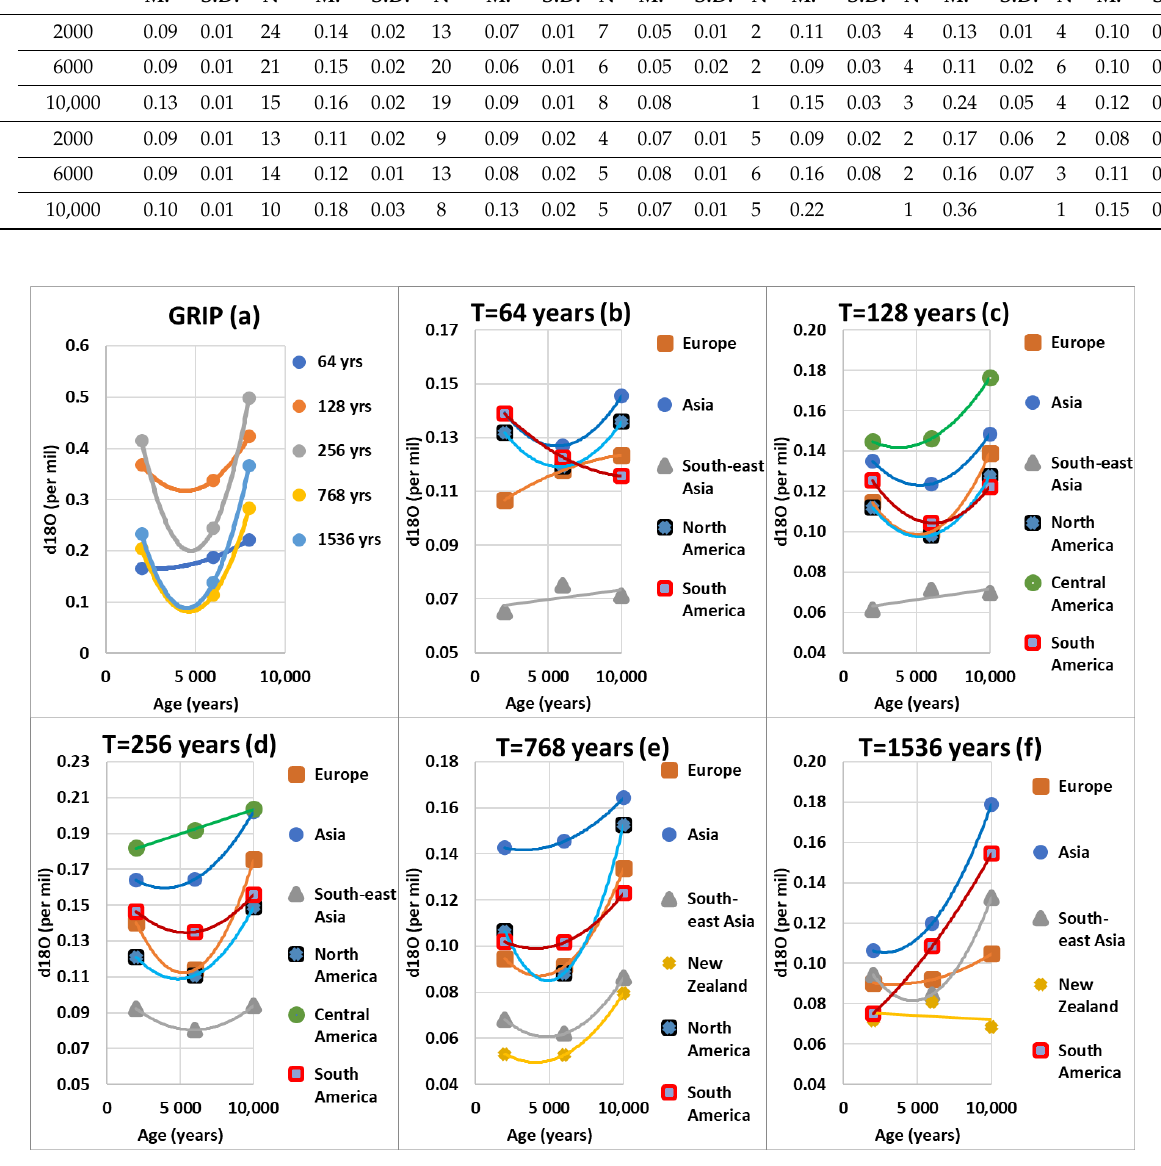
图 9 Figure 9. Used as a paleorecord versus the subharmonic modes, amplitude of δ 18 O variations throughout the Holocene. ( a ) In GRIP ice core record; ( b – f ) in speleothems located in the seven regions. Mean periods are T = 64 ( b ), 128 ( c ), 256 ( d ), 768 ( e ), and 1536 ( f )